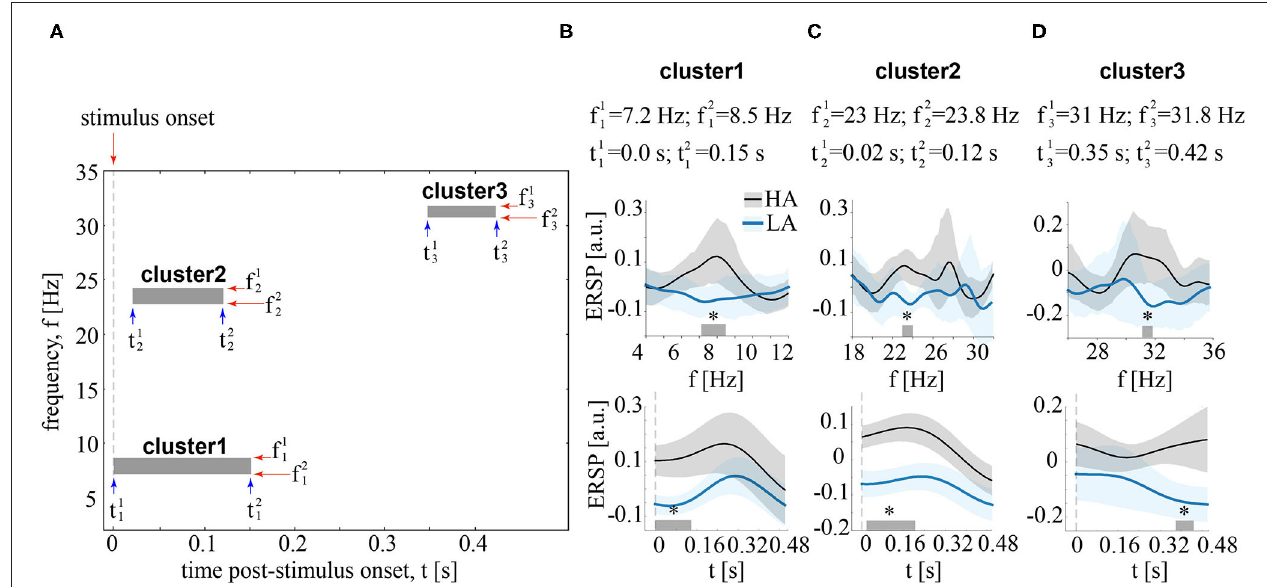
FIGURE 4 | (A) Boxes show clusters in the time-frequency domain reflecting the significant differences of EEG power, event-related spectral perturbation (ERSP) between HA and LA stimuli. (B–D) contain information about the time and frequency ranges of each cluster and show ERSP averaged over these time (upper row) and frequency (bottom row) ranges. ERSP is shown for LA and HA stimuli as the group means and 95 % confidence intervals, ∗ p < 0.05 via the paired t -test, corrected via a cluster-based approach with 2000 Monte-Carlo randomizations.